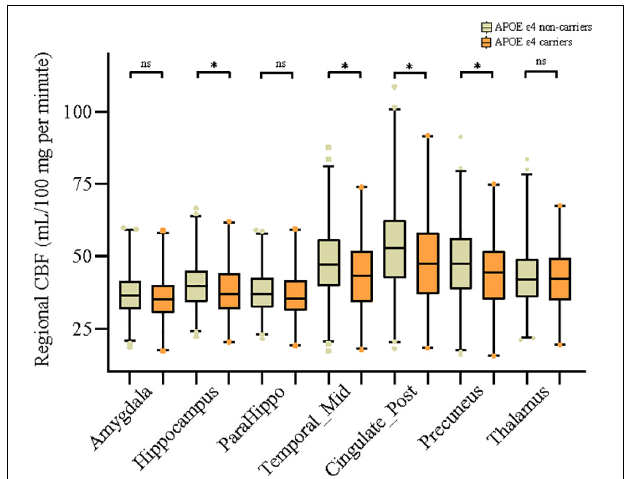
FIGURE 1 | Associations of APOE ε 4 allele with mean cerebral blood flow (CBF) of 7 different brain regions. Comparisons between groups were analyzed using t -tests. The asterisks mean significant, and ns indicates non-significant.